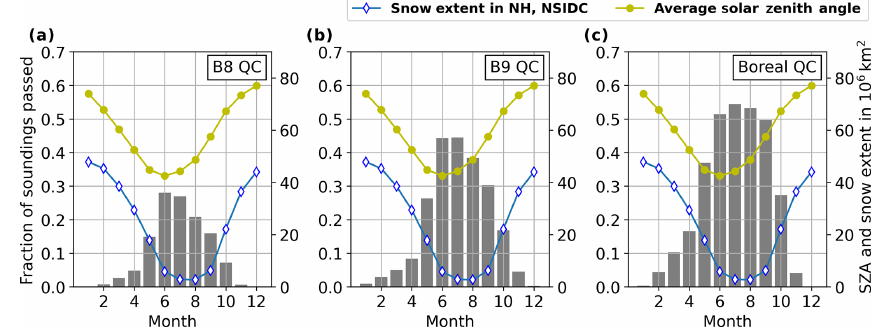
Figure 7. The fraction of soundings that pass each set of QC filters for each month out of all land soundings north of 50 ◦ N in the OCO-2 Lite files (note that OCO-2 observations are filtered by a preliminary cloud screening before being compiled in the Lite files). Also plotted are the average solar zenith angles reported in OCO-2 retrievals that pass in each month and the monthly snow extent in the Northern Hemisphere, averaged over 2014–2018, as reported in the NOAA database (Robinson et al.,